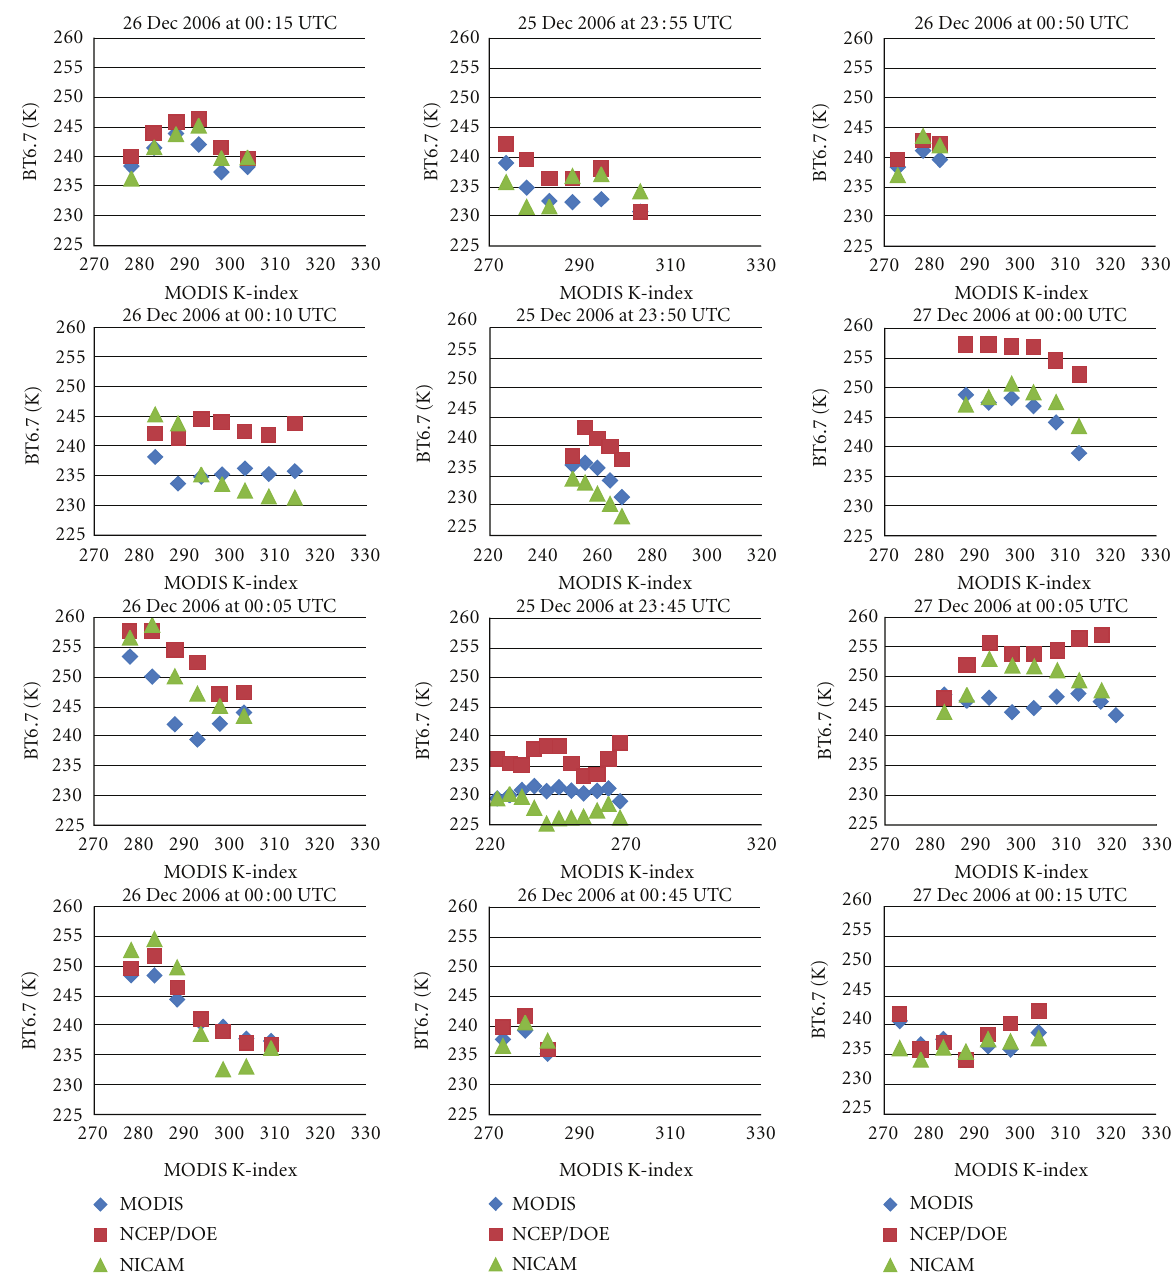
Figure 5: Variation of MODIS K-index with observed brightness temperature at 6.7 μ m wavelength (BT6.7) in K. Obs-NCEP: di ff erence between observations and NCEP/DOE, Obs-NICAM: di ff erence between observations and NICAM.